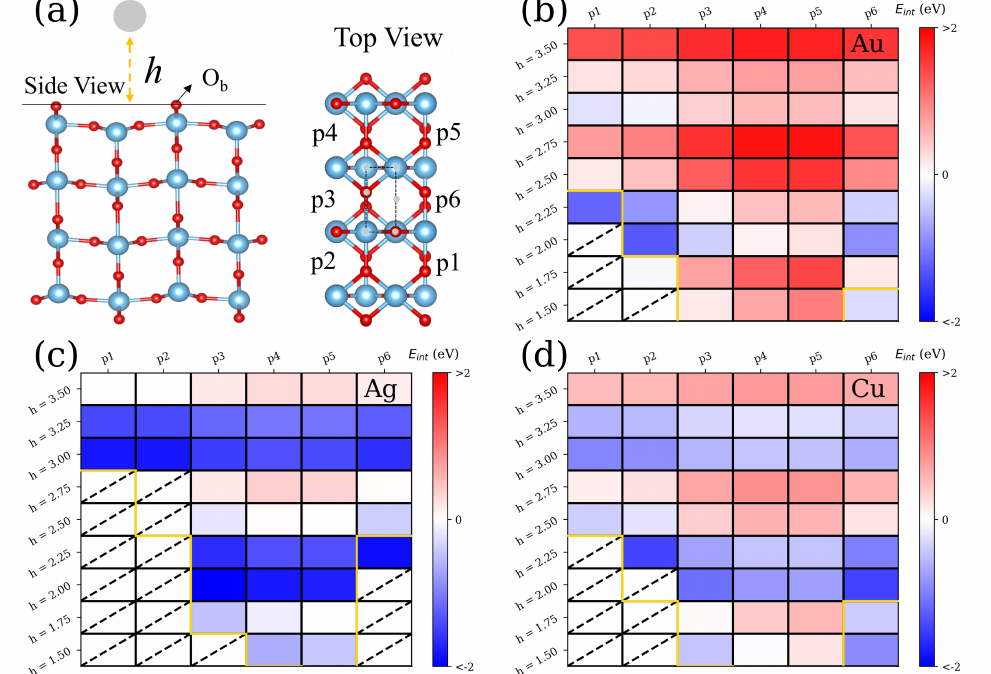
Figure 1. Schematic representation ( a ) of atomic structure of deposited Me s on optimized rutile TiO 2 (110) surface with various height (h) at designed positions (p1 to p6). Interaction energies ( E int ) of ( b ) Au, ( c ) Ag, and ( d ) Cu adatoms on TiO 2 surface are shown with the red–blue color pattern. The diagonal dashed-line is for the Me s adatoms on TiO 2 surface with self-consistent field non-convergence; the yellow lines mean that there is a bond between Me s and surrounding surface